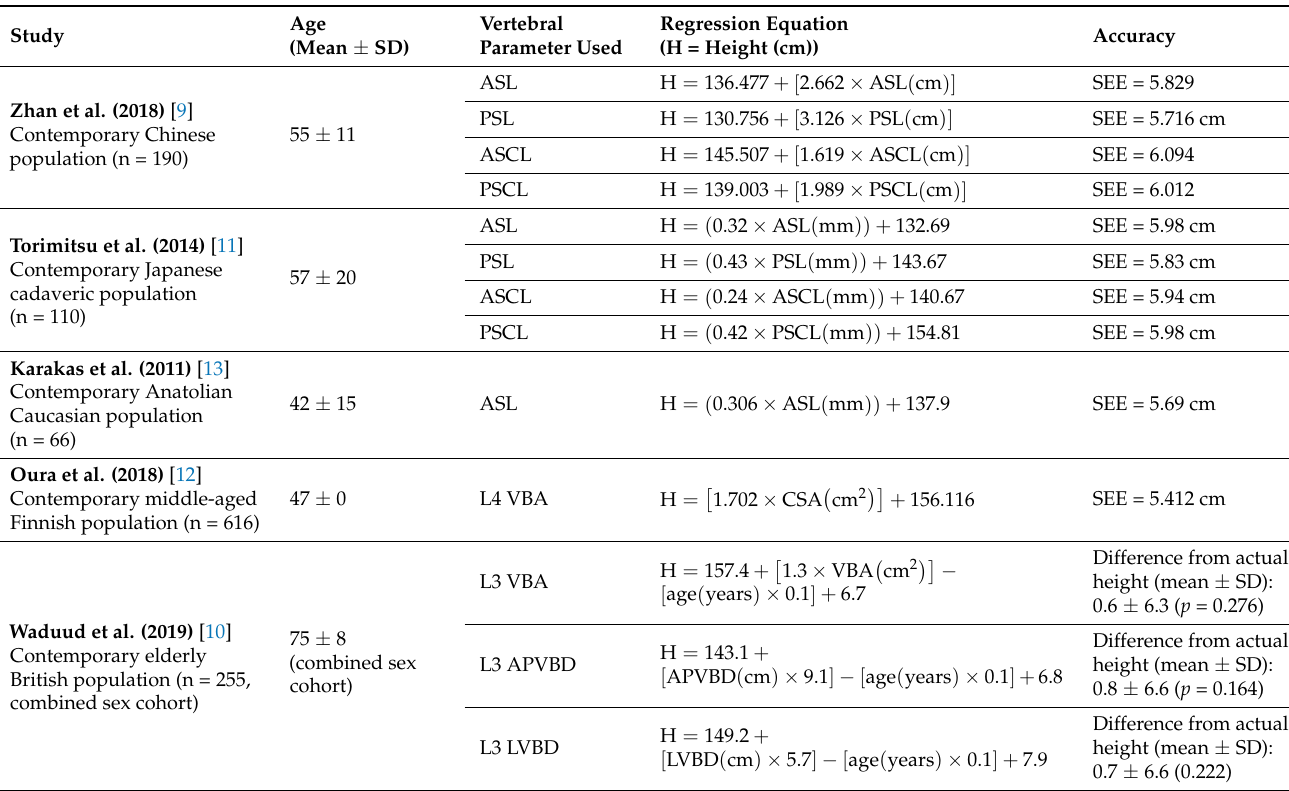
Table 2. Regression equations used to generate height estimates for male